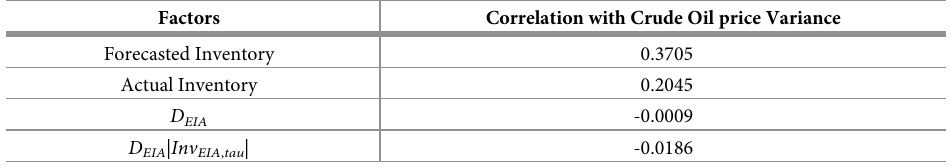
Table 3. Correlation between one of the inventory factors and crude oil price variance.